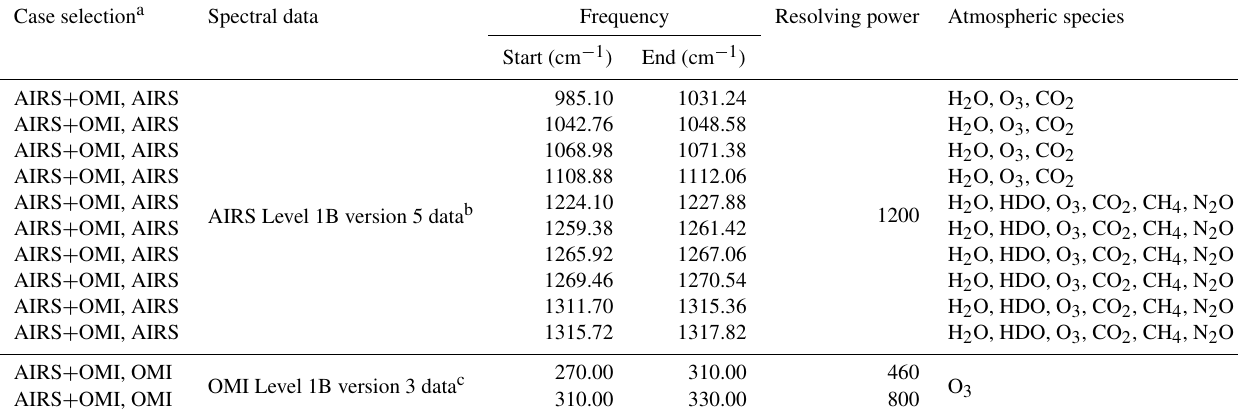
Table 1. Spectral regions used in ozone retrievals.